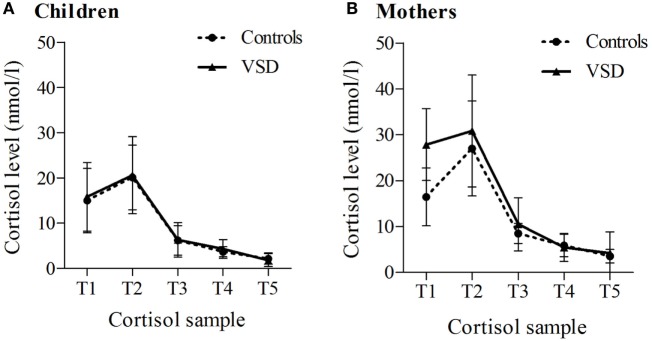
Diurnal cortisol profiles separately for ventricular septal defect (VSD) vs. control group, for children (A) and their mothers (B). Mean values and 95% confidence intervals are displayed. Default sampling times: T1 = at awakening, T2 = 30 min after awakening, T3 = 12:00 p.m., T4 = 5:00 p.m., and T5 at bedtime (n = 31–49).